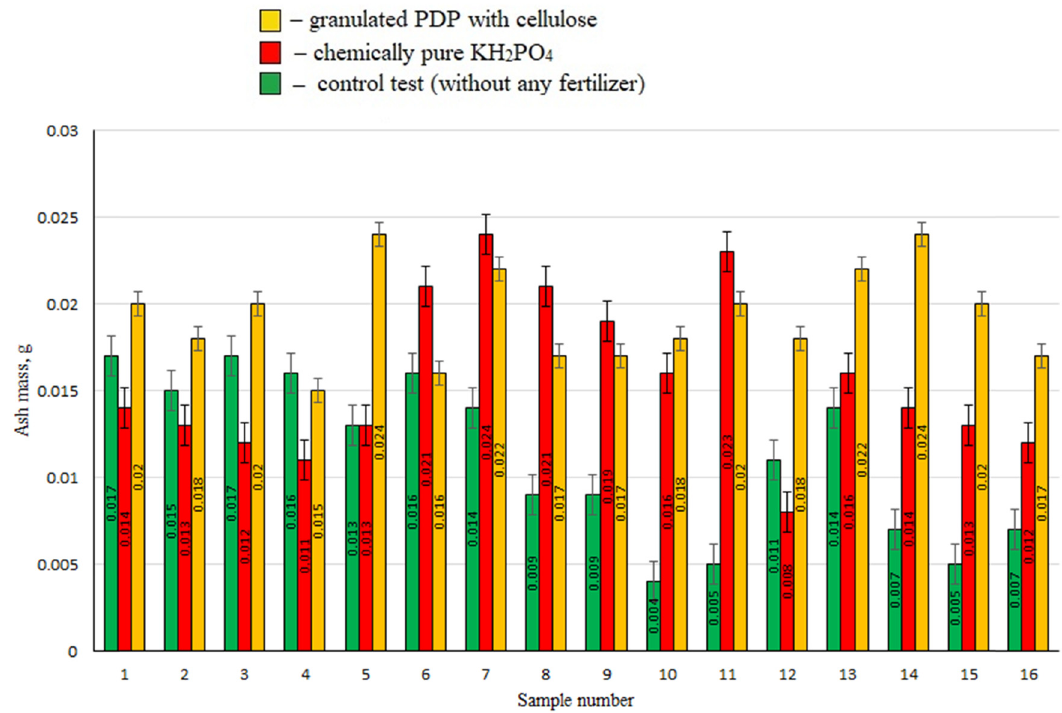
Figure 7: Leaf ash mass dependence on the type of